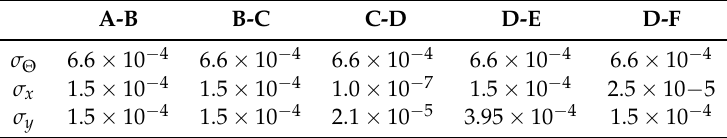
Table 4. Sigma values used in our